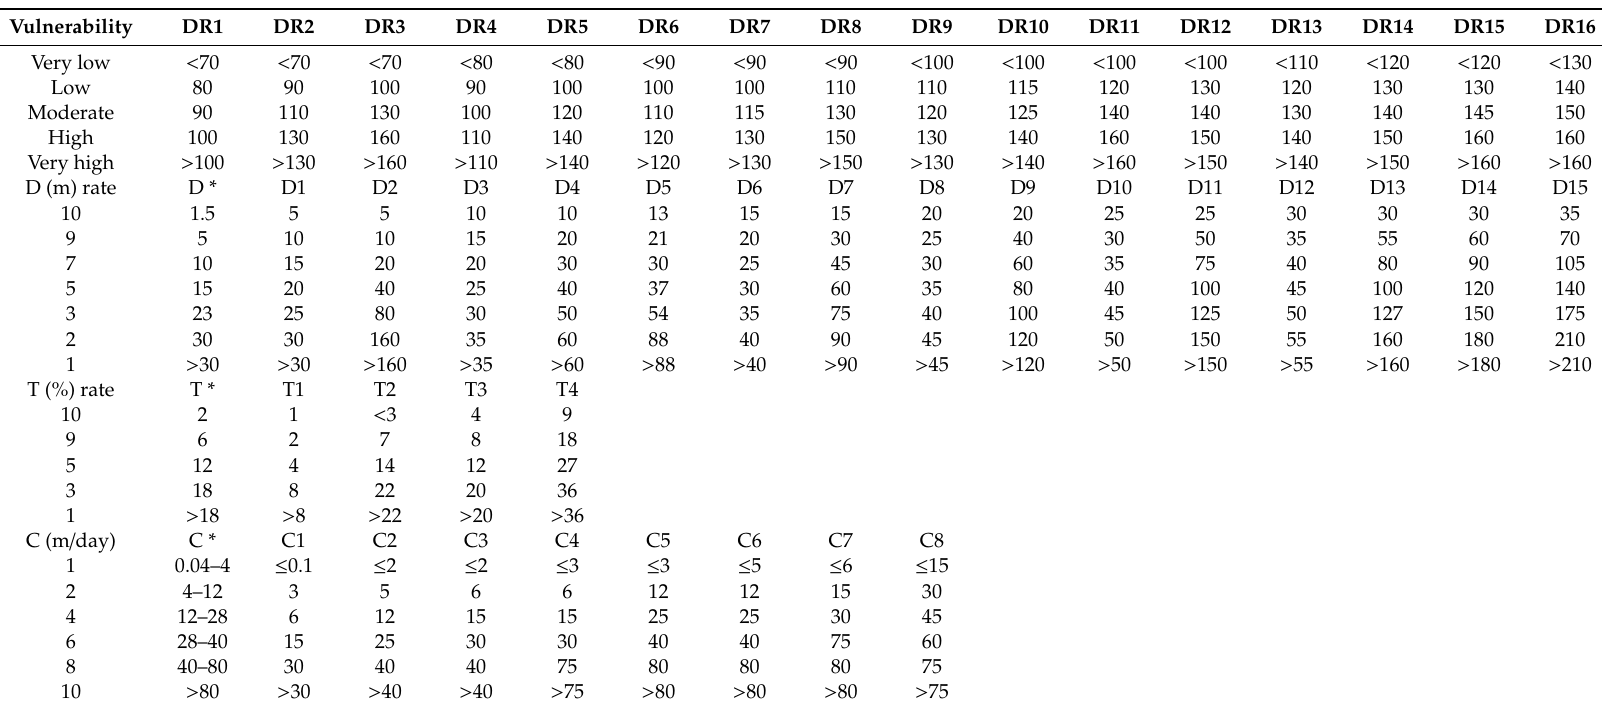
Table 2. Proposed classifications for the parameters and DRASTIC